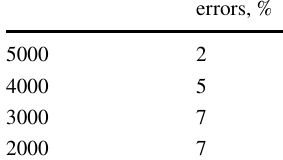
Table 6 Relative errors